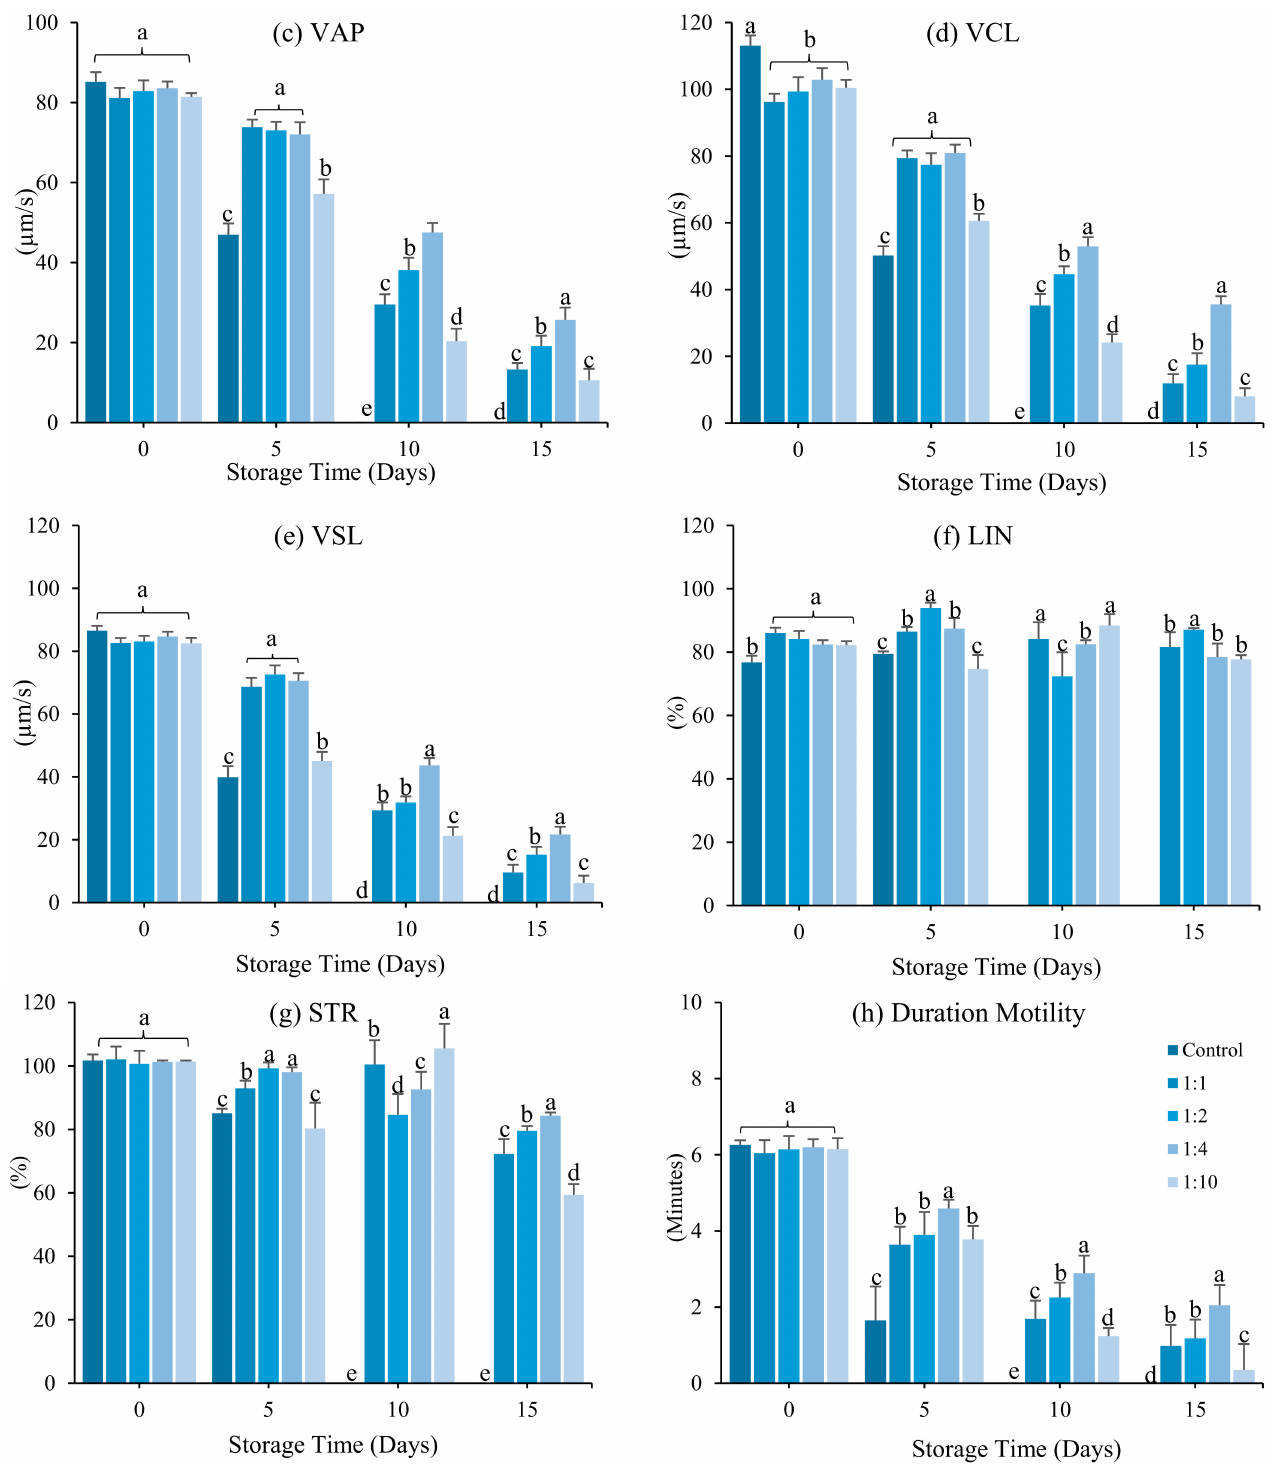
Figure 2. Effect of dilution ratio (sperm: Stein’s solution) on sperm of spotted halibut ( Verasper variegatus ) stored for 15 days at 4 ◦ C. ( a ) Motility (%), ( b ) cell viability (%), ( c ) average path velocity (VAP; µ m/s), ( d ) curvilinear line velocity (VCL; µ m/s), ( e ) straight-line velocity (VSL; µ m/s), ( f ) linearity (LIN; %), ( g ) straightness (STR; %) and ( h ) duration motility (minutes). Various lowercase letters represent substantial changes across dilution ratio ( p < 0.05). Control, fresh